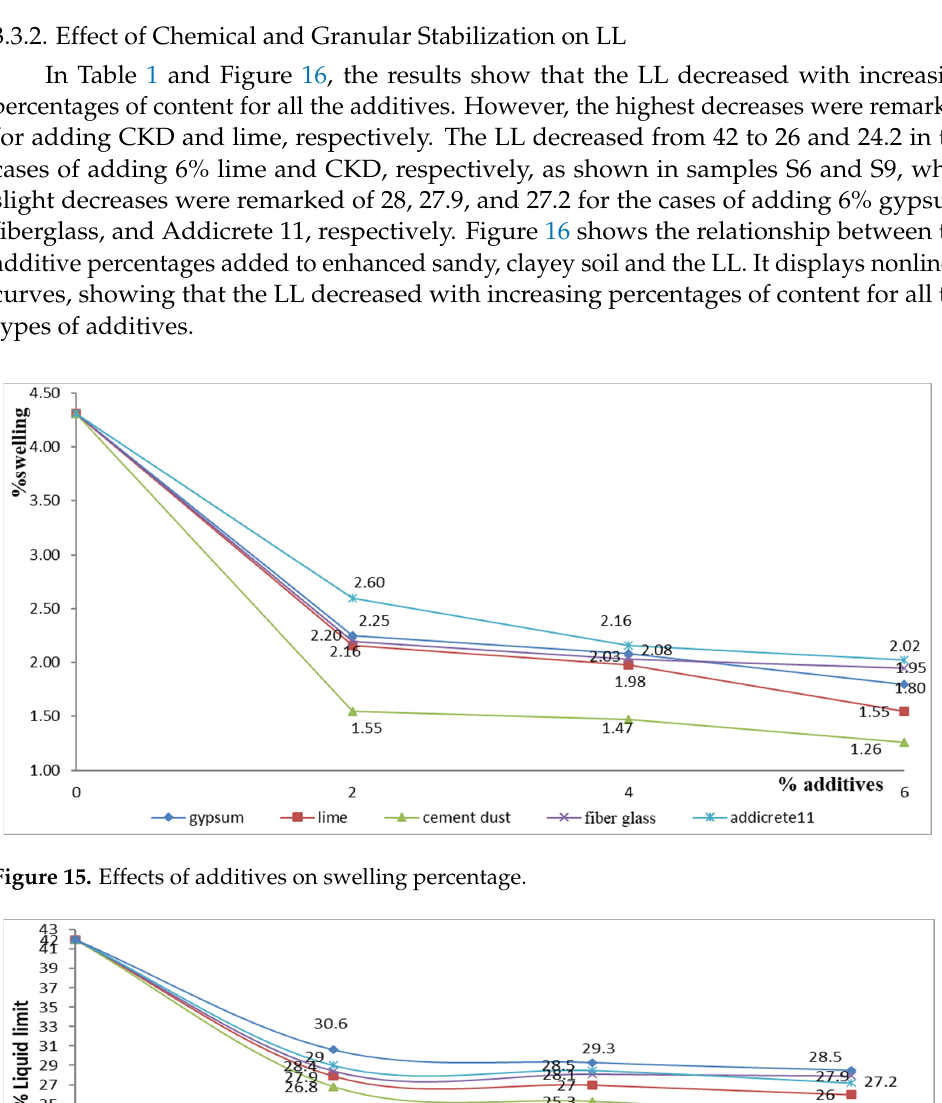
Figure 16. Effect of additives on the liquid limit.